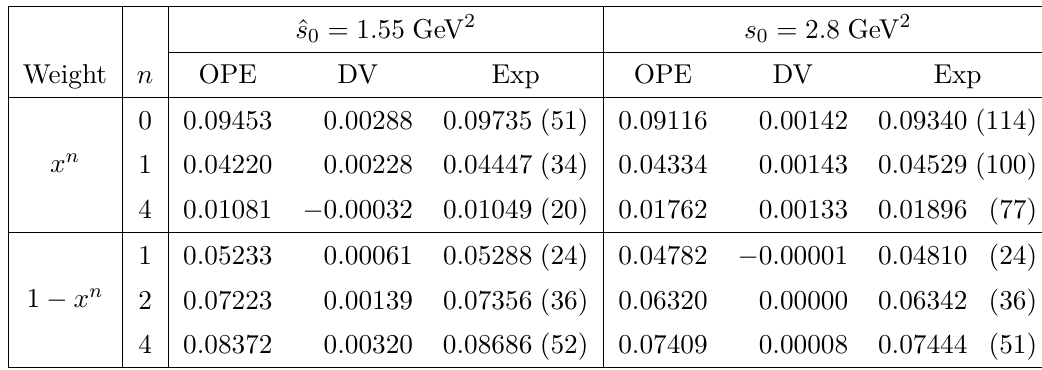
( s ) , together with the fitted 0 V ( x ) = x n and 1 − x n , using the default ansatz. n = 1 . 55 GeV 2 and s = 2 . 8 GeV 2 0 0